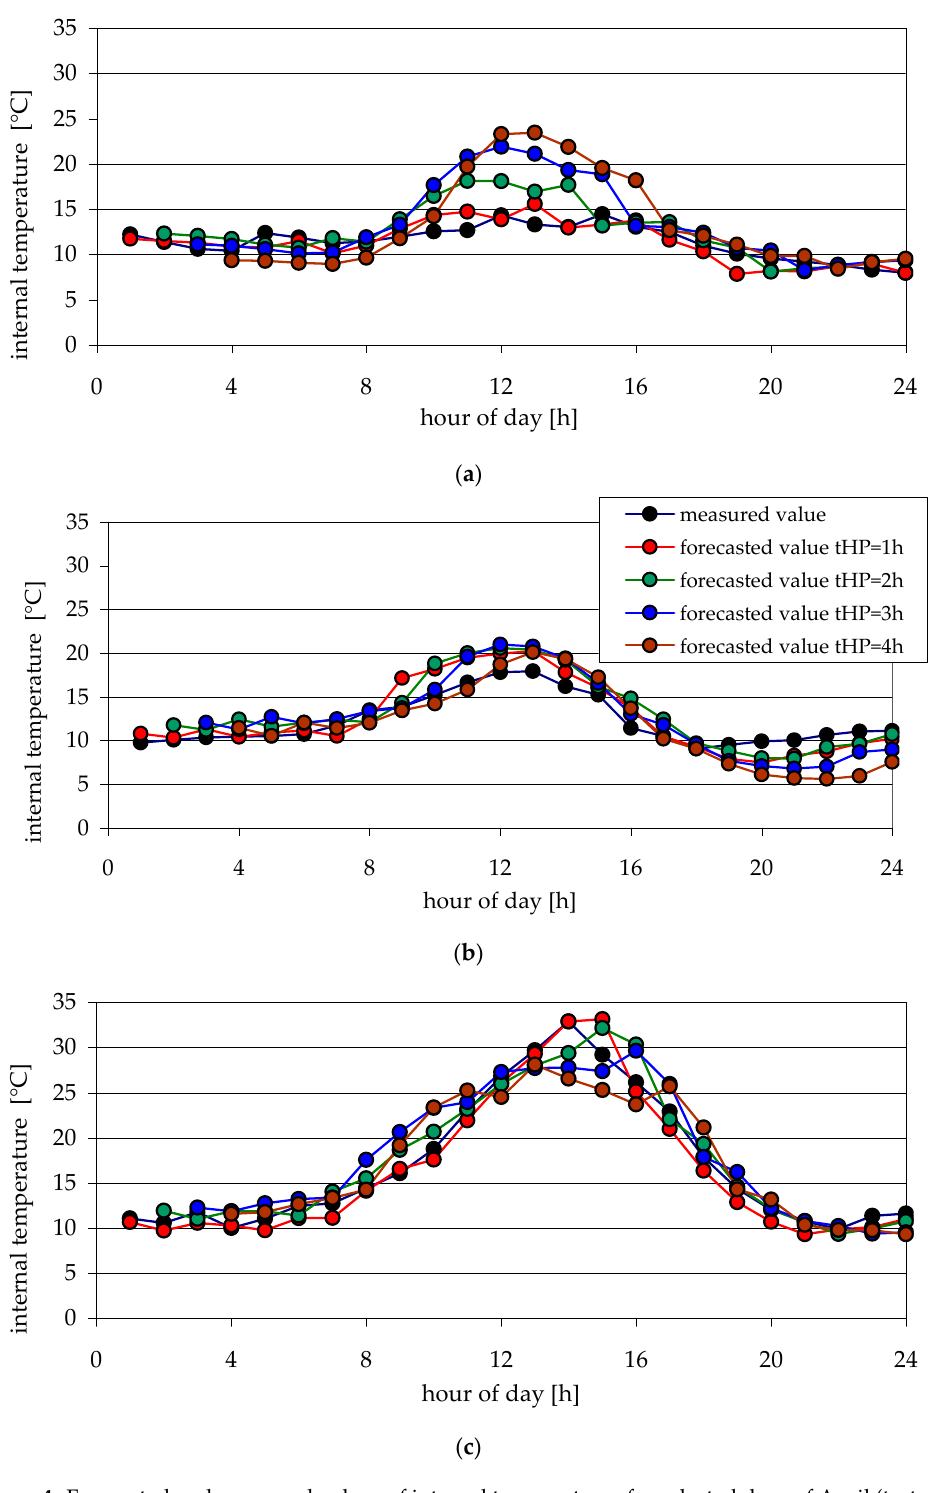
Figure 4. Forecasted and measured values of internal temperatures for selected days of April (test data) for various forecast time horizons: ( a ) 3th April; ( b ) 8th April; ( c ) 19th April.